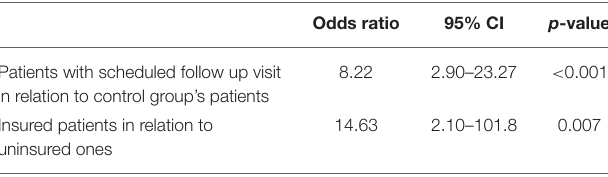
TABLE 4 | Multivariate logistic regression (Dependent variable: Visiting the ED, more than once, due to asthma attacks followed by non-admission).